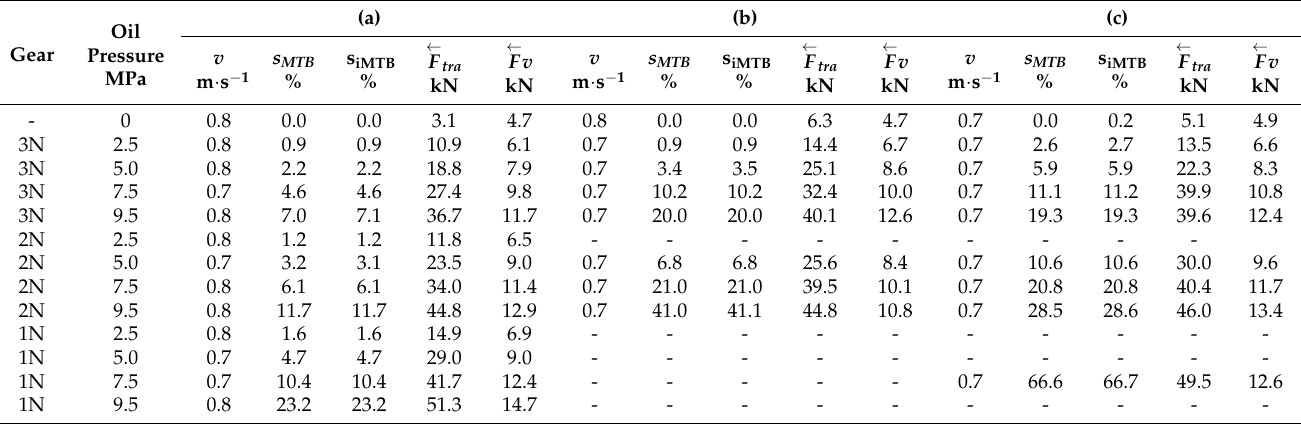
Table 5. Mean values of the test parameters (speed, slip and forces) observed during Test A with